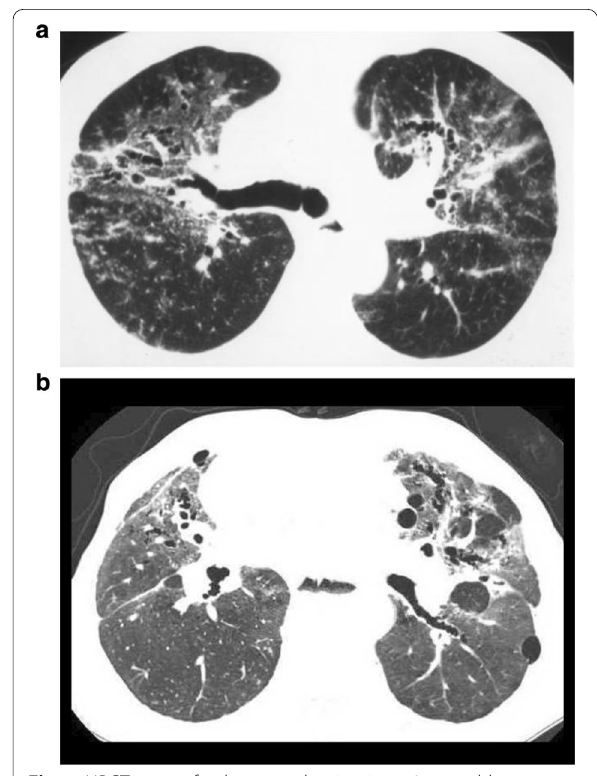
Fig. 4 HRCT scans of pulmonary aluminosis. a 58-year-old man with pulmonary aluminosis. HRCT scan of pulmonary aluminosis mimicking sarcoidosis. Ground-glass opacities, small nodular opacities, and traction bronchiectasis are seen predominantly around the bronchovascular bundles. Nodules are located in both centrilobular and paralobular regions. b 52-year-old man with pulmonary aluminosis. HRCT shows traction bronchiectasis and ground-glass opacity predominantly in the upper lungs.